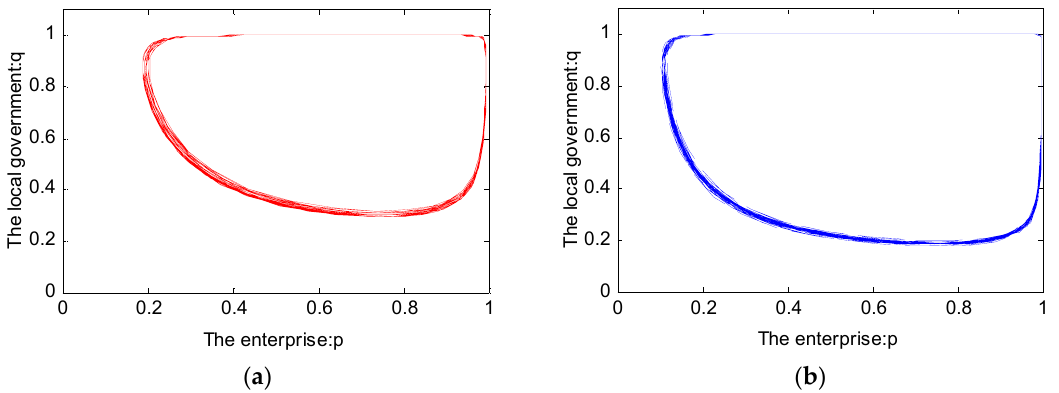
Figure 6. The simulation analysis between the local government and the enterprise. ( a ) p t ( 0 ) = 0.2, q t ( 0 ) = 0.8 and ( b ) p t ( 0 ) = 0.8, q t ( 0 ) =